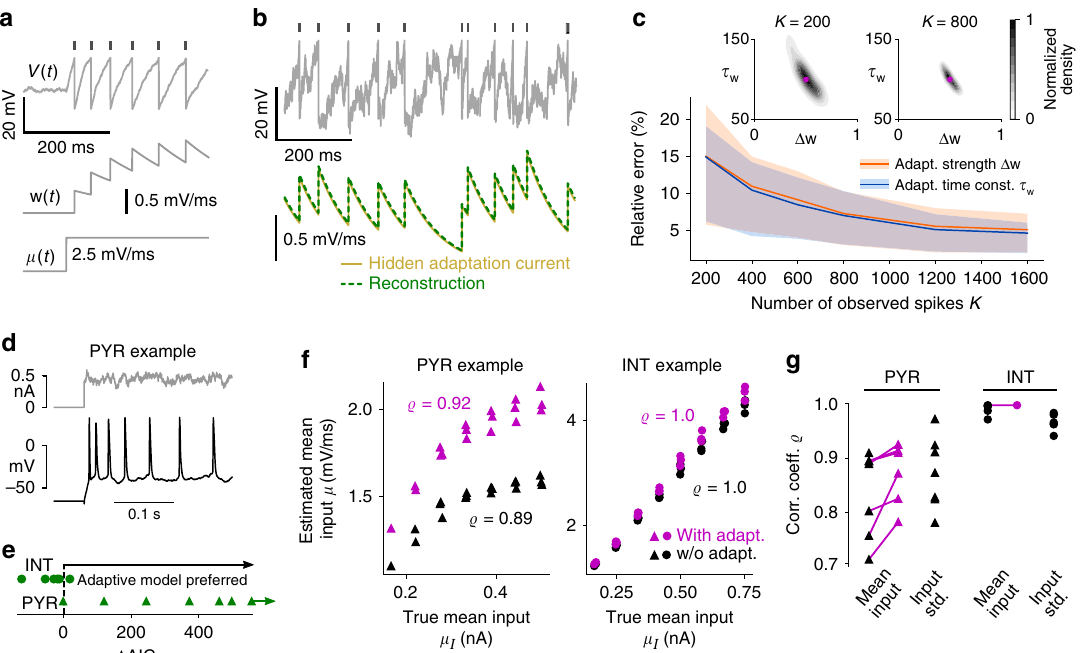
Fig. 7 Estimation results for neuronal adaptation using synthetic and in vitro data. a Membrane voltage with indicated spike times (top) and adaptation variable (center) of an adaptive leaky I&F neuron in response to a step of mean input (bottom, for small input noise intensity σ ). b Example membrane voltage and true adaptation current time series as well as the reconstruction using estimated adaptation parameters Δ w , τ w (based on 1000 spikes) and the observed spike times. The adaptation current is considered as normalized by the (unknown) membrane capacitance and therefore in units of mV/ms. Method 1 was used for estimation. c Mean and central 50% (i.e., 25 – 75th percentile) of relative errors between estimated and true values for Δ w and τ w as a function of number of spikes K . Insets: empirical density of estimated parameter values with true values indicated for K = 200 and K = 800. d Example recorded membrane voltage in response to an injected noisy step current showing spike rate adaptation. e AIC difference ( Δ AIC) between the nonadaptive and adaptive leaky I&F models for all seven PYRs and six INTs. f Estimated mean input μ as a function of empirical mean input μ I for the adaptive and nonadaptive models (magenta and black symbols, respectively) for two example cells. ϱ denotes Pearson correlation coef fi cient. g ϱ for input mean and standard deviation for the two models and all neurons. Estimation results in ( e – g ) were obtained using 15 s long stimuli (corresponding to three repetitions of 5 s stimuli with equal